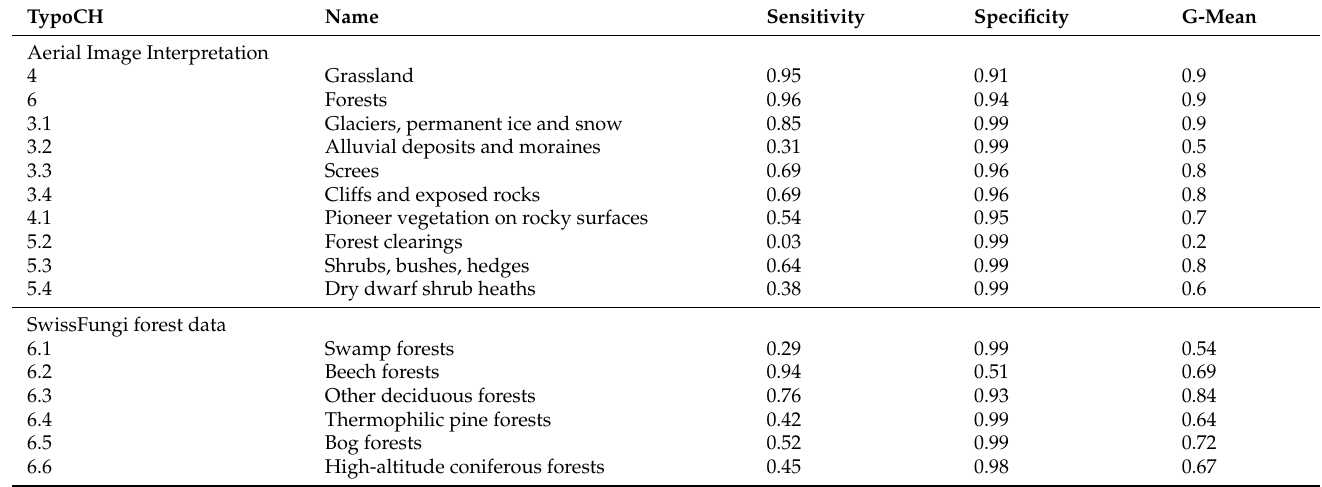
Table 6. Results of the validation comparison between the Habitat Map of Switzerland and the aerial image interpretation and the SwissFungi